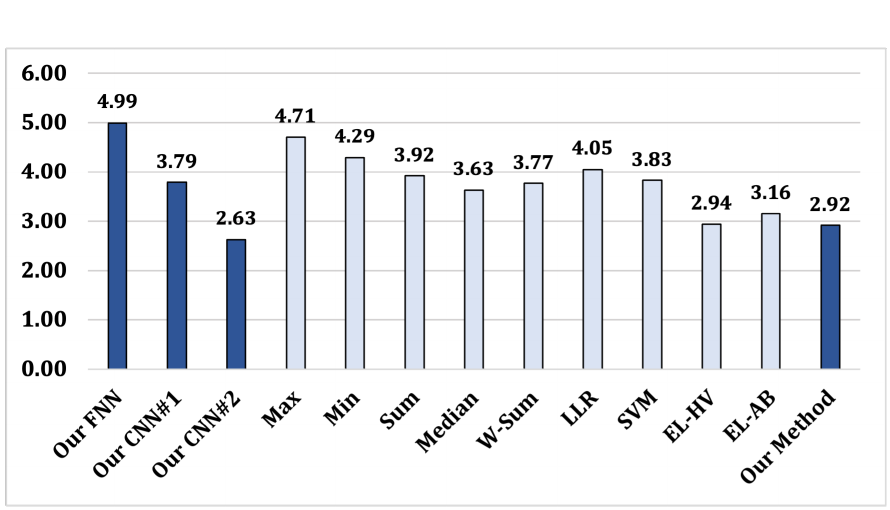
Figure 3. Fusion methods: The mean ACC differences between